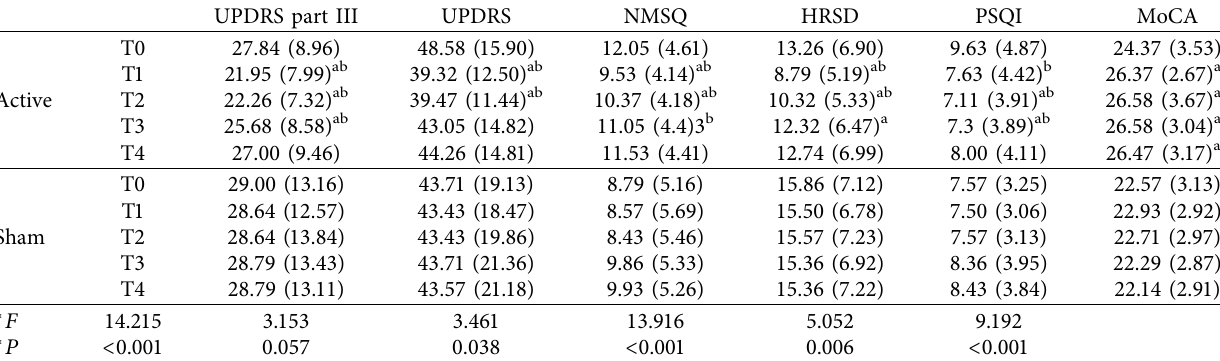
Figure 2: Score change of primary outcome on UPDRS part III and NMSQ in active and sham rTMS group. Table 3: Secondary outcome comparisons between active and sham rTMS